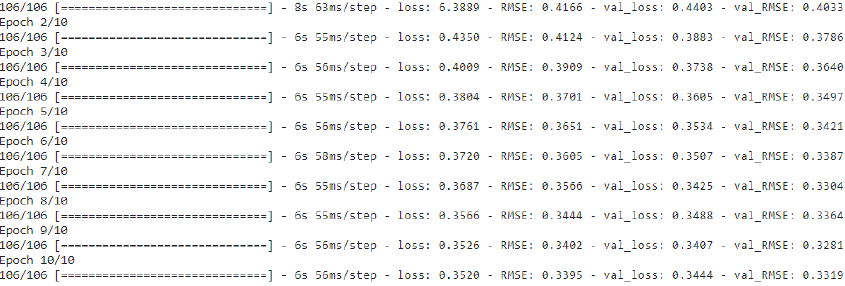
Figure 35. Recommendation model deep learning process.